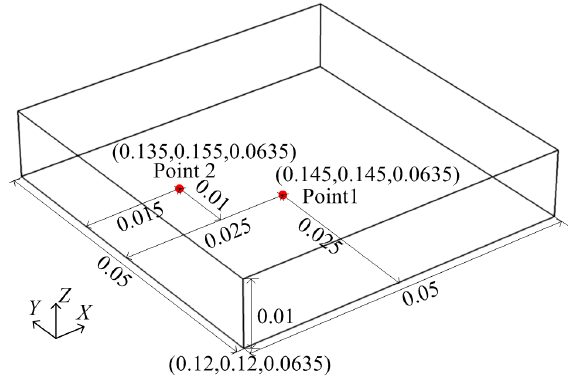
Figure 5. Position of the fiber-optic sensors (unit: m).